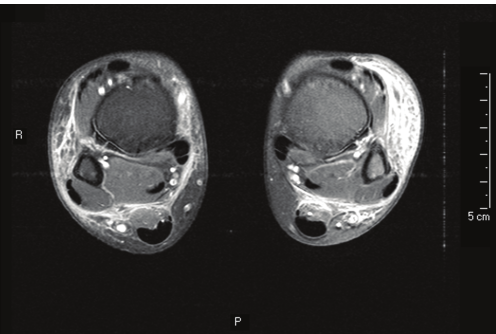
Figure 1: Magnetic resonance imaging of ankles and legs (coronal T2 and axial T1) showing bilateral cellulitis. Images show an exten- sive signal alteration of the subcutaneous soft tissues in both legs with dishomogeneous enhancement after contrast, consistent with an inflammatory involvement (cellulitis). A bilateral small intra- articular collection can be seen, without significant enhancement after contrast. Neither alterations in muscles and tendons, nor signs of osteomyelitis are